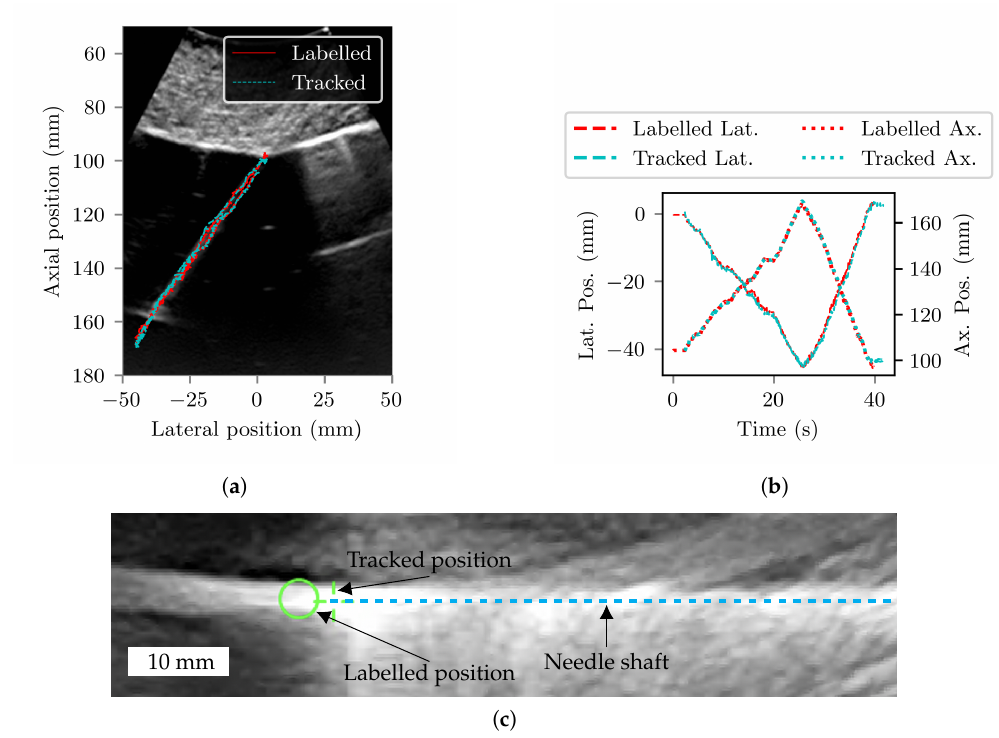
Figure 12. ( a ) Trajectory of the needle during the homogenous medium accuracy assessment accord- ing to manual labelling (solid red) and tracked positions generated by the UNT system (dotted blue), plotted on top of a representative B-mode US image acquired during the insertion. ( b ) Manually labelled (red )and tracked (blue) lateral and axial positions of the needle tip are plotted against time. Axial positions are relative to the centre of curvature of the US probe. A screen recording of the UNT software interface made during this insertion is provided as Supplementary Material. ( c ) Cropped US image of the needle during the water experiment showing the difference between tracked (in this case, approximately equal to true in) and labelled positions, and therefore the difficulty identifying the position of the needle tip by manual labelling of the US images. The distance between the two positions is approximately